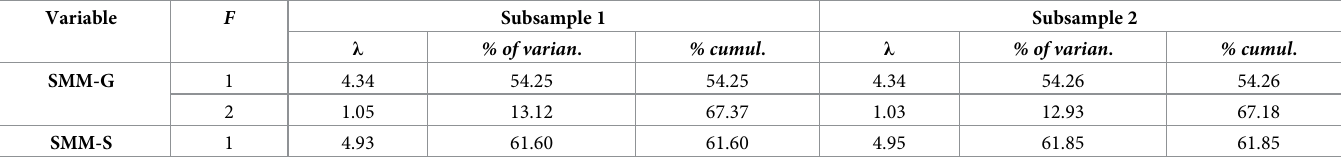
Table 3. EFA results for the SMM-G and SMM-S: Initial Eigenvalues and total variance explained. Variable F Subsample 1 Subsample 2 λ % of varian . % of varian . % cumul